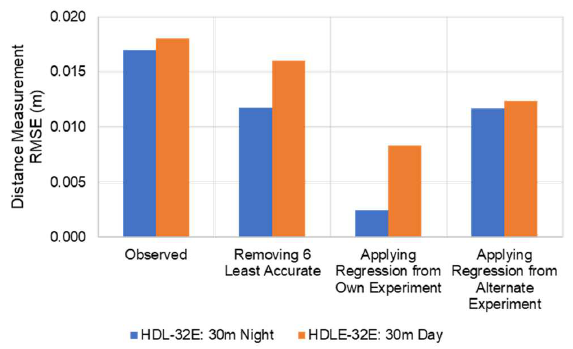
Figure 39. Application of error mitigation techniques on Velodyne ® HDL–32E measurements.